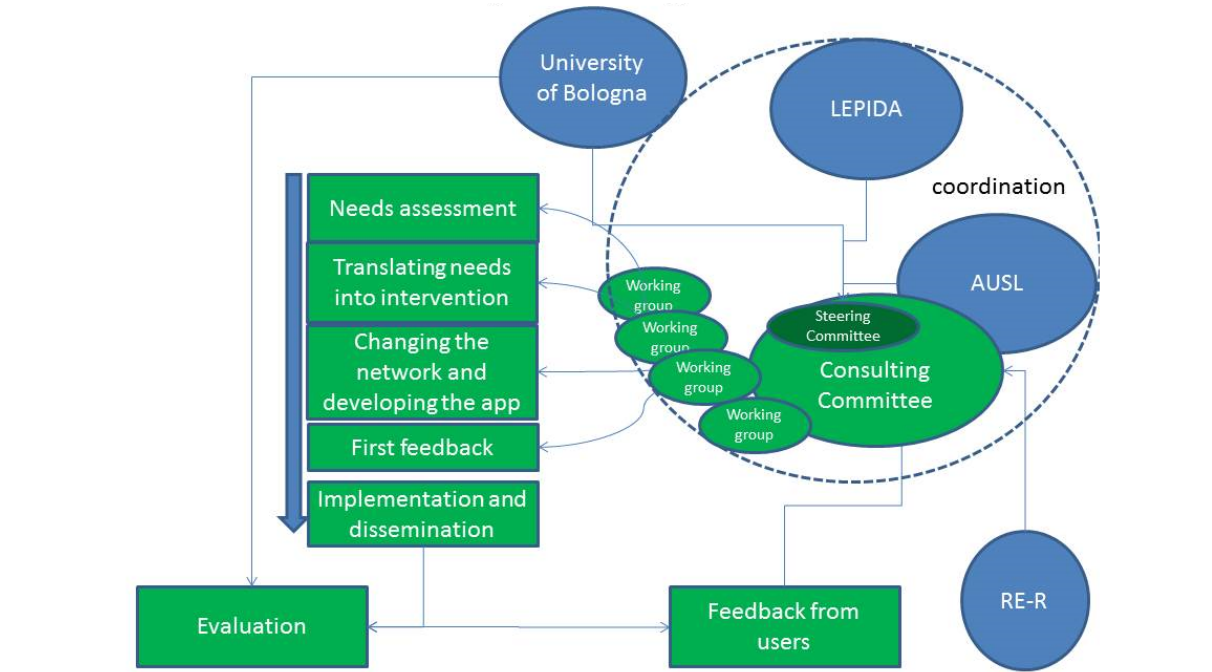
Figure 2. Project management